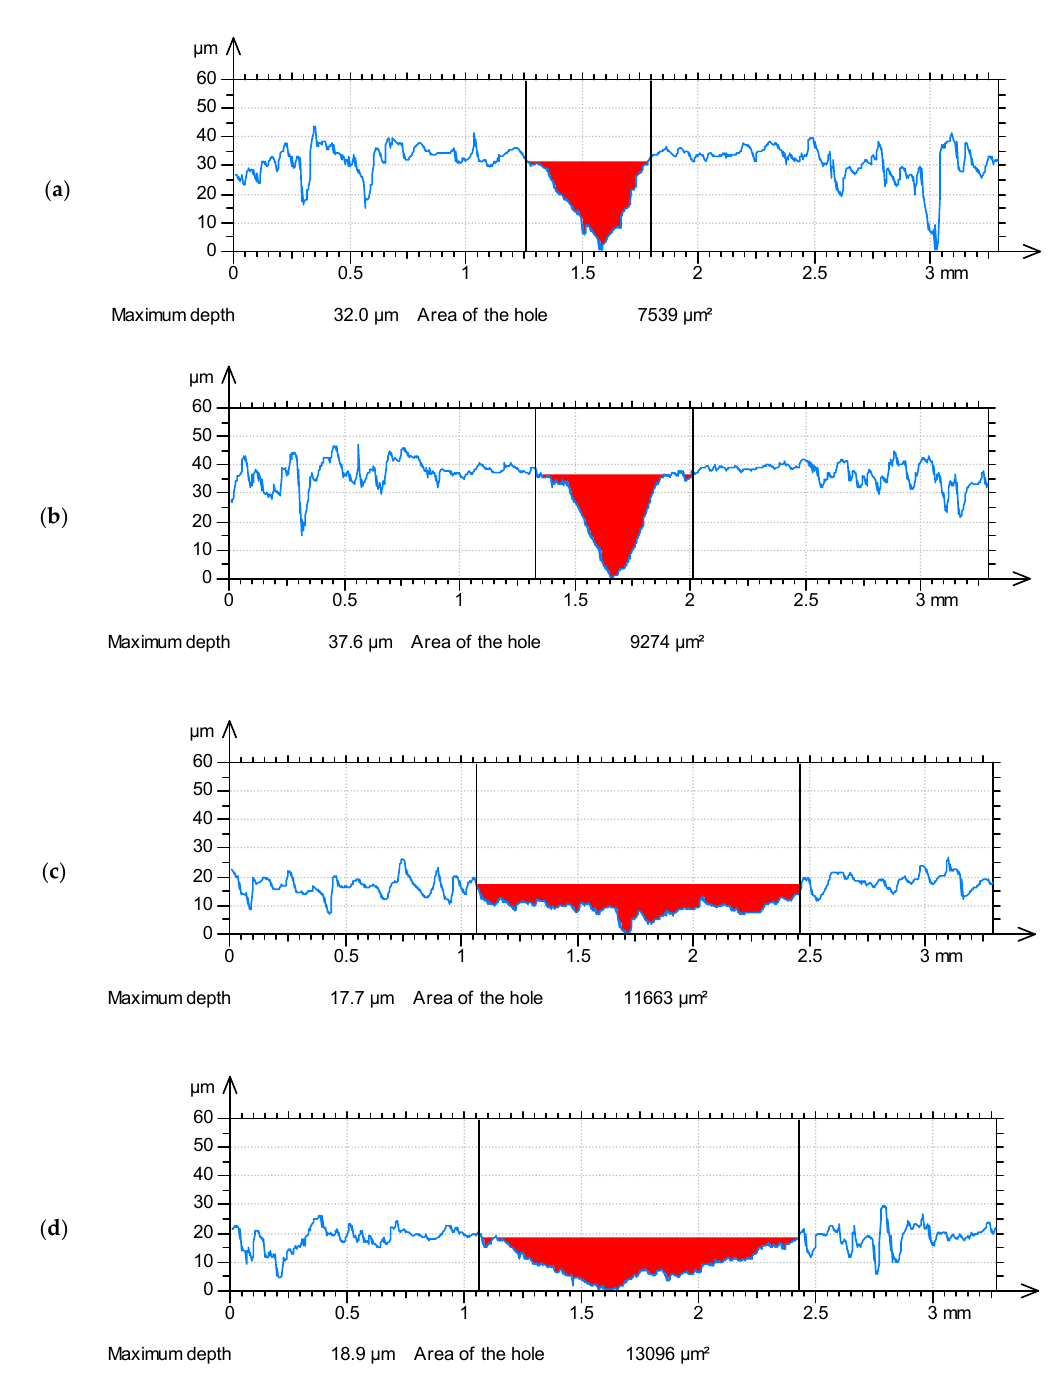
Figure 5. Cross-sectional areas of worn discs: S1 ( a ), S3 ( b ), S4 ( c ), S8 ( d ) at the sliding speed of v = 0.16 m/s.